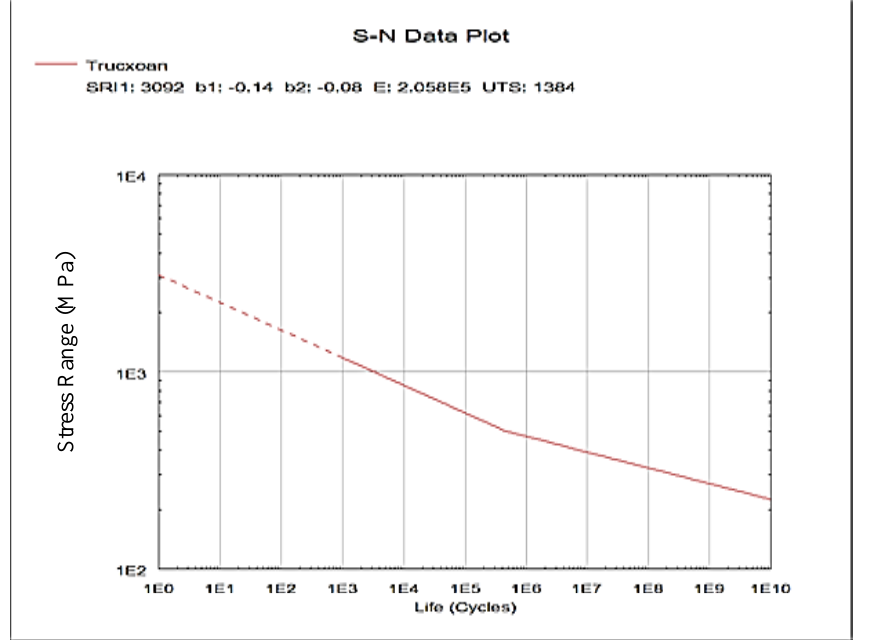
Figure 9. Stress - life curve of torsion bar [17].